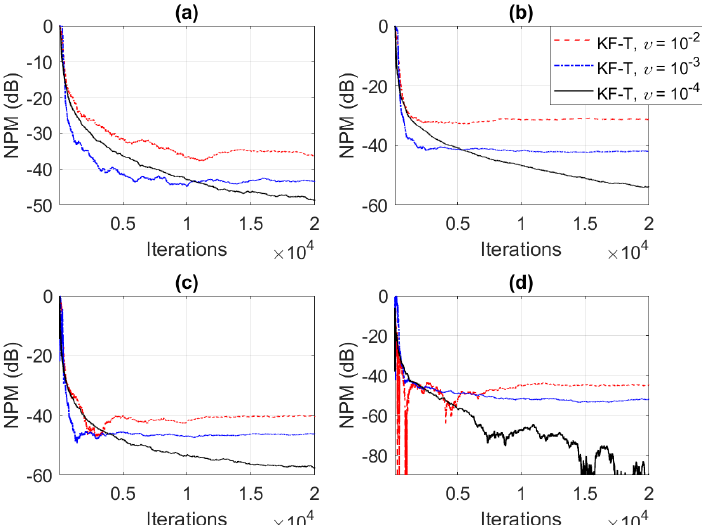
= 0, n = 1,2, . . . , N Figure 13. Normalized projection misalignment (NPM) of the KF-T using σ 2 w n for the identification of the individual impulse responses, h n ( t ) , n = 1,2, . . . , N , which result from the decomposition of h ( t ) + u ( t ) , where u ( t ) is randomly generated (Gaussian distribution), with (cid:104) (cid:105) (cid:104) (cid:105) h 1 ( t ) , (cid:98) h 1 ( t ) h 2 ( t ) , (cid:98) h 2 ( t ) variance υ (cid:107) h ( t ) (cid:107) 2 / L , using different values of υ . ( a ) NPM , ( b ) NPM , (cid:104) (cid:105) (cid:104) (cid:105) h 3 ( t ) , (cid:98) h 3 ( t ) h 4 ( t ) , (cid:98) h 4 ( t ) ( c ) NPM , and ( d ) NPM .